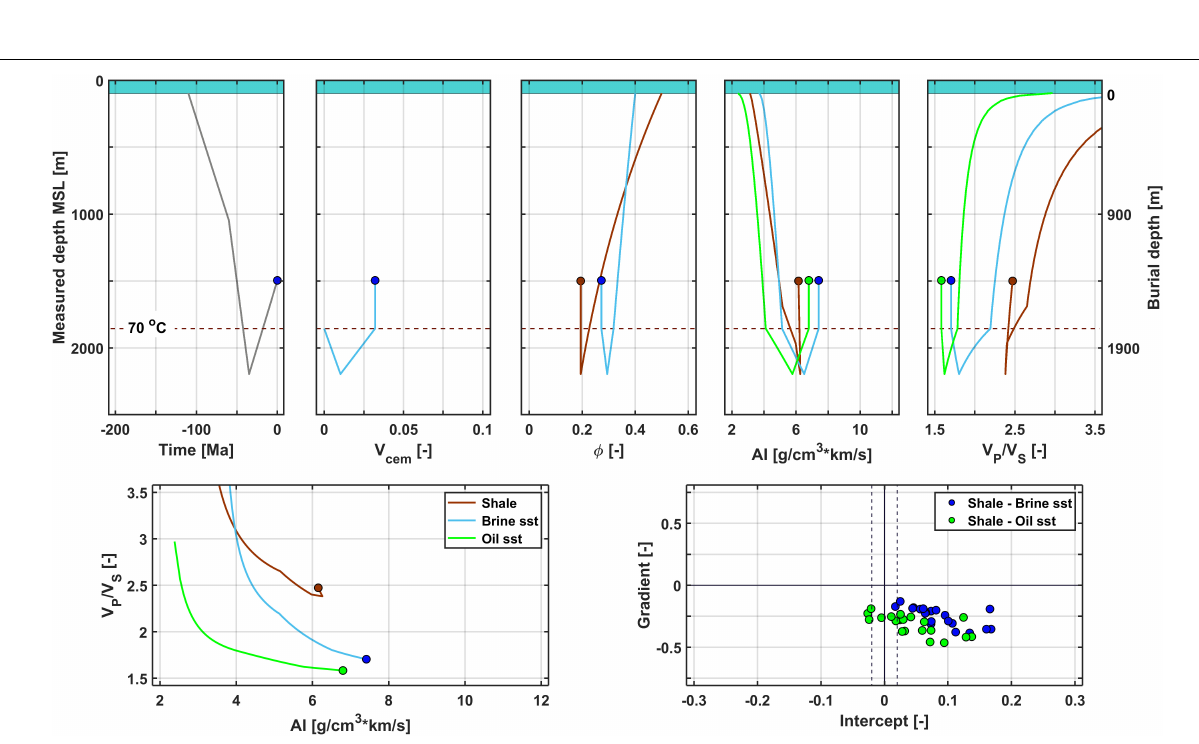
Frontiers in Earth Science |